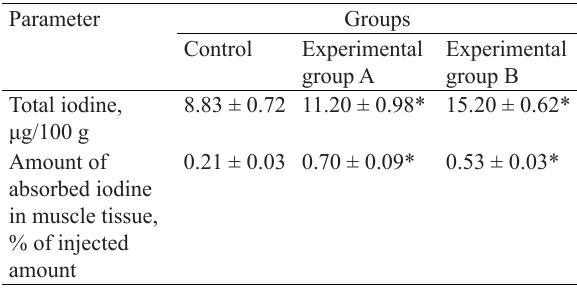
Table 6 Iodotyrosine content in pig muscle tissue Parameter Groups Control Experimental Experimental group A group